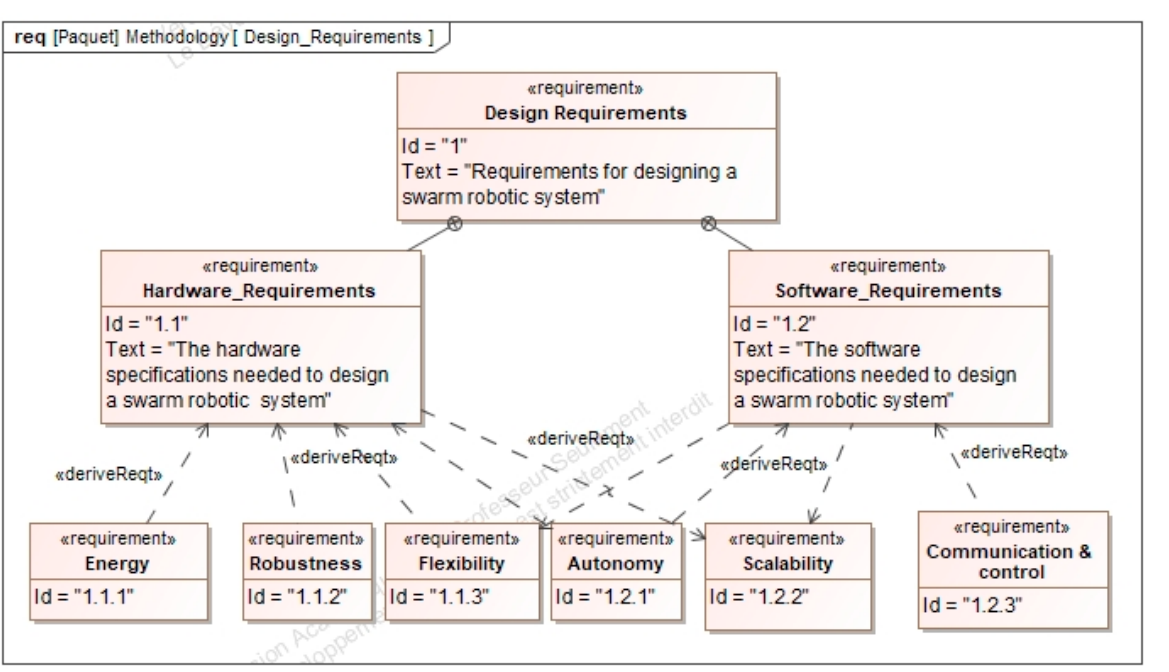
Figure 3. Design requirements of a swarm robotic system in SysML.